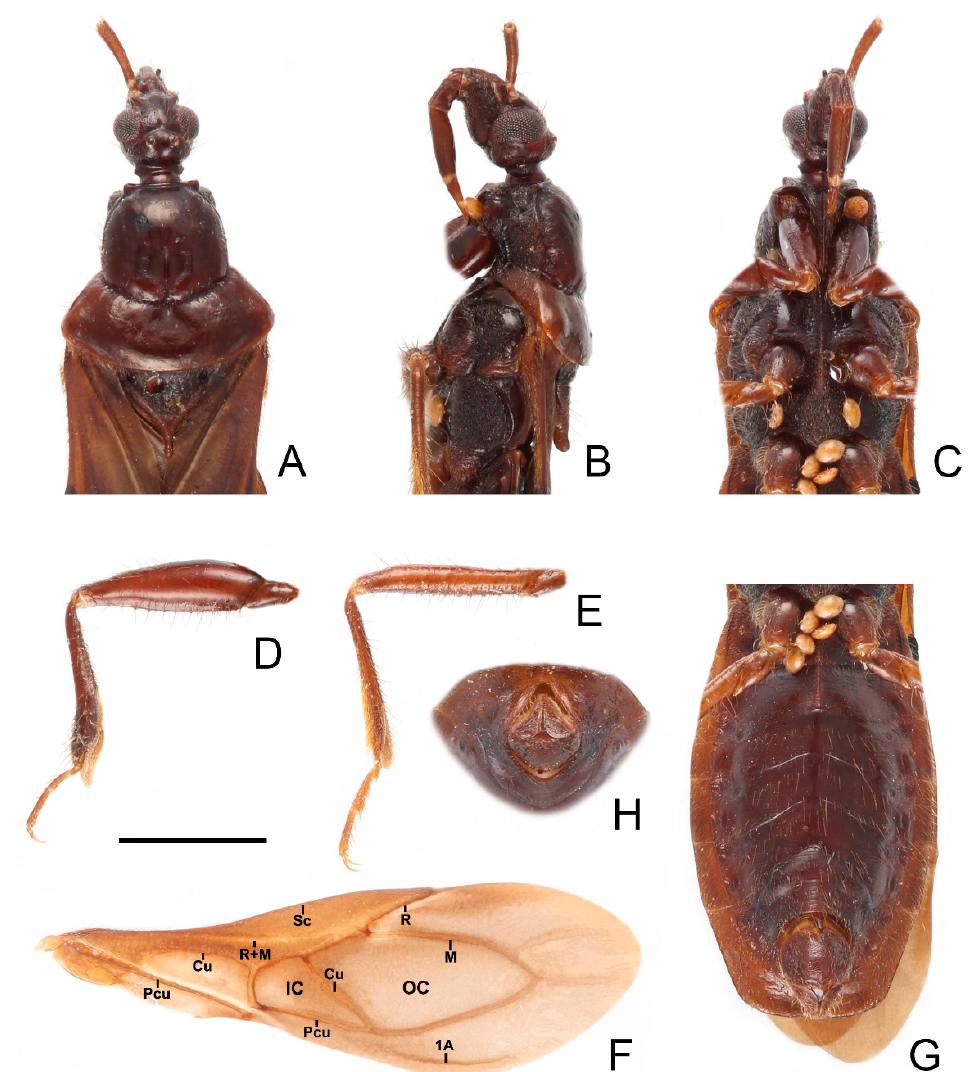
Figure 8. Sigicoris dominiqueae sp. nov. , paratype male. ( A ) Anterior part of body with antennae and legs removed, dorsal view; ( B ) ditto, lateral view; ( C ) ditto, ventral view. ( D ) Left fore leg, ventral view. ( E ) Right mid leg, ventral view. ( F ) Right hemelytron, dorsal view. ( G ) Abdomen, ventral view; ( H ) ditto, caudal view. Scale bar = 2.00 mm. Abbreviations: 1A, first analis; Cu, cubitus; M, media; Pcu, postocubitus; R, radius; Sc, subcosta; IC, inner cell on membrane; OC, outer cell on